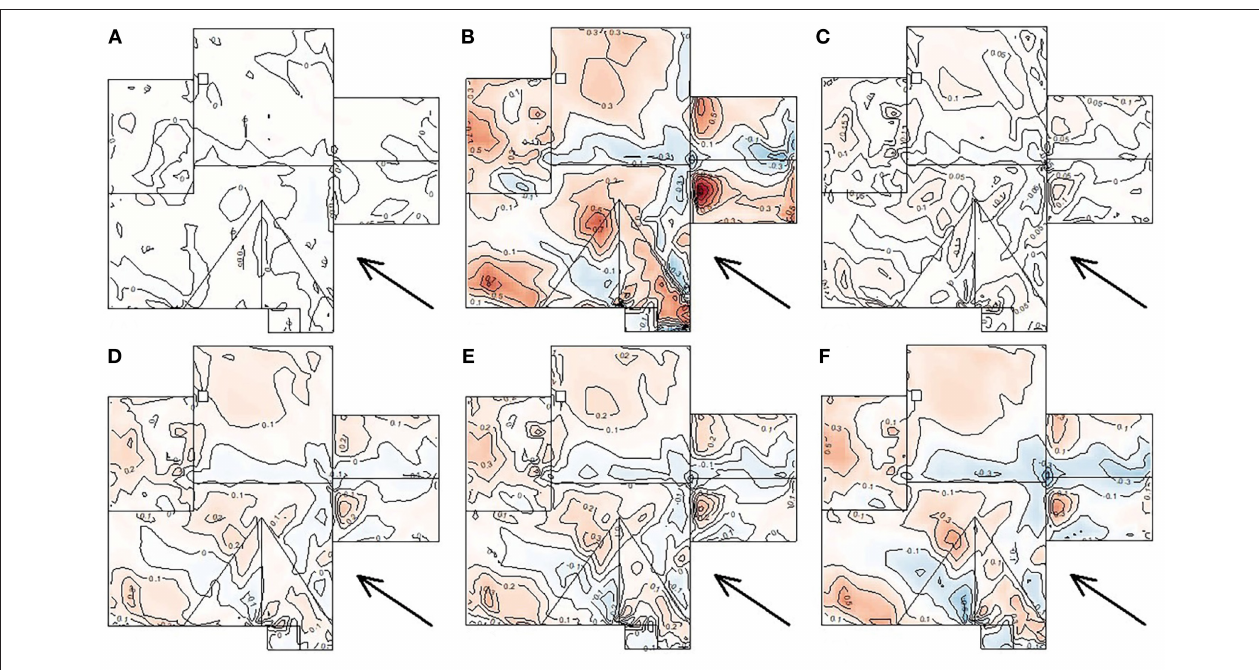
FIGURE 11 | Spatial distribution of the average anomaly for each method: (A) EVA N = 16 and T = 10min ( N peak = 11), (B) YGP T = 60min ( N peak = 30), (C) XIMIS T = 160min ( N